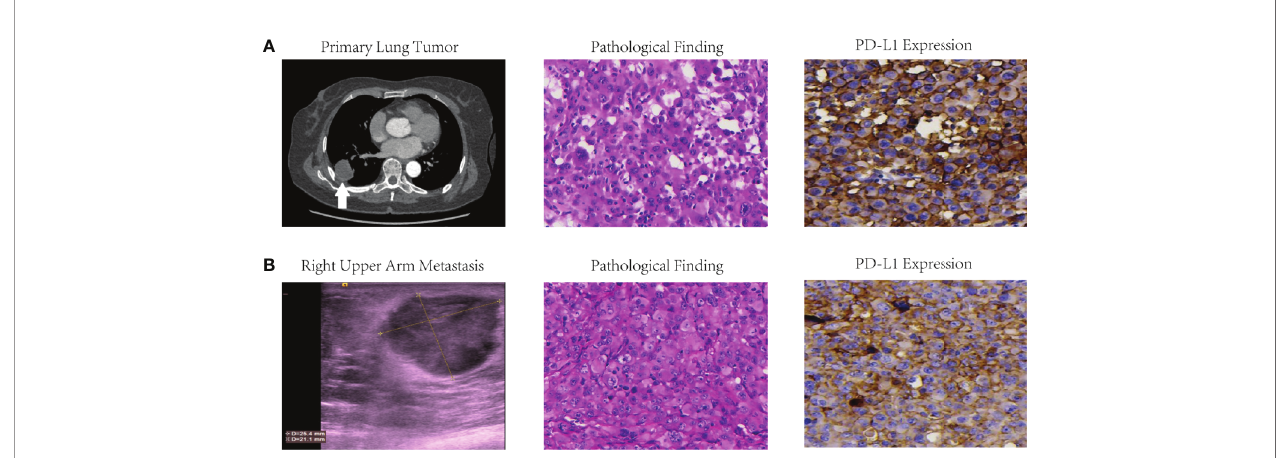
FIGURE 1 | Imaging fi ndings, pathological results and PD-L1 expressions of primary lung tumor (A) and right upper arm metastasis (B) in this LCLC case. Initial CT scan revealed a primary lung tumor in right lower lobe, and color ultrasound scan at 1 month after operation presented a right upper arm metastasis. Pathological results of both foci were con fi rmed LCLC with microscope magni fi cation at 400×. Immumohistochemistry fi ndings demonstrated PD-L1 expression with TPS 60 – 70% for the primary tumor and TPS 40 – 49% for right upper arm